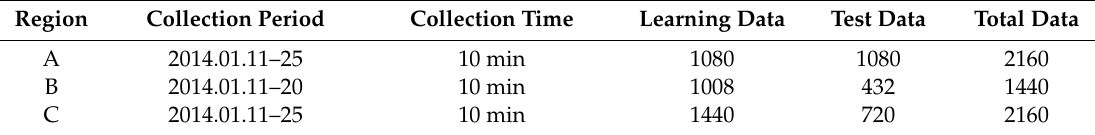
Table 1. Collection period, collection time, learning and testing data of each region.